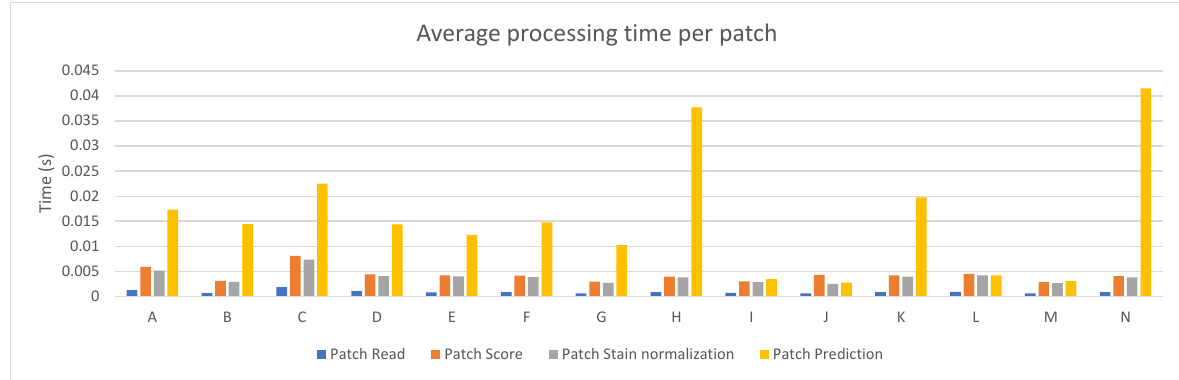
Figure 2. PROMETEO average patch processing time (in seconds) per step for each of the hardware configurations detailed in Table A1.